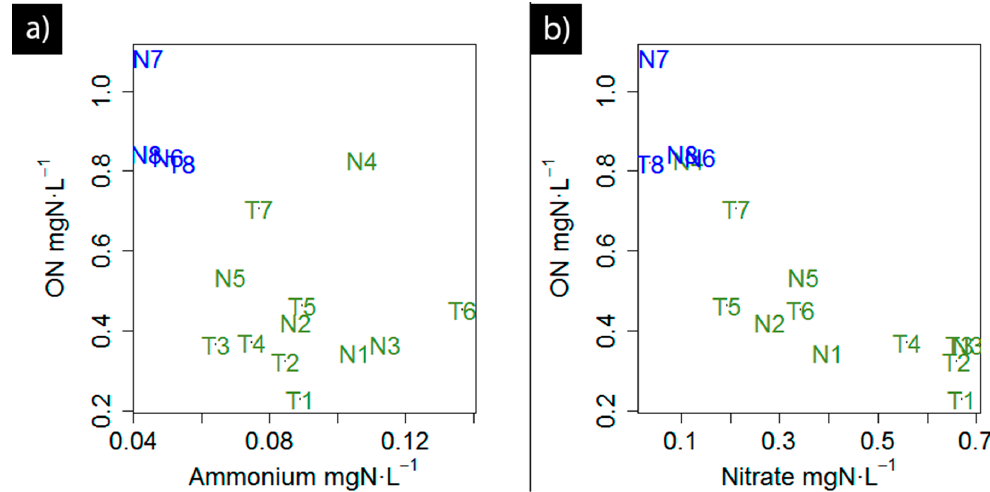
Figure 4. Scatterplot of ( a ) organic nitrogen versus ammonium and ( b ) organic nitrogen versus nitrate. The cluster “coast” is plotted in blue and the cluster “rivers” in green.